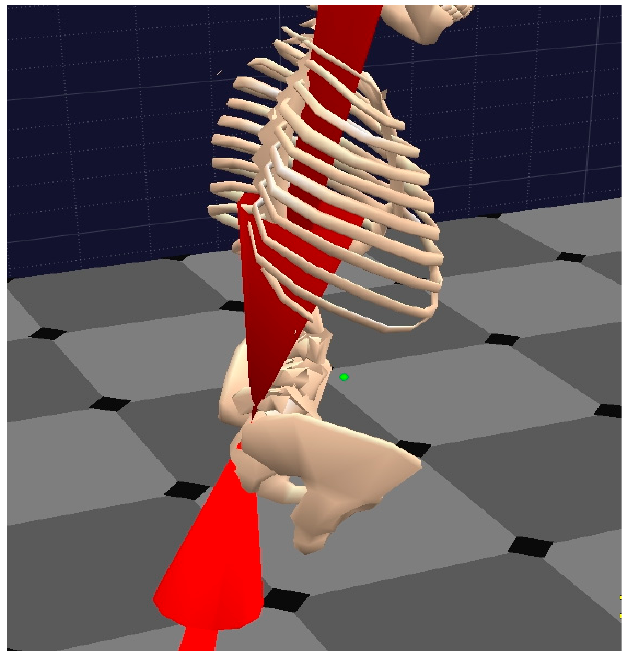
Figure 2. Pinch force 3D vector representing the compression force at the L5 ‐ Pelvis junction.